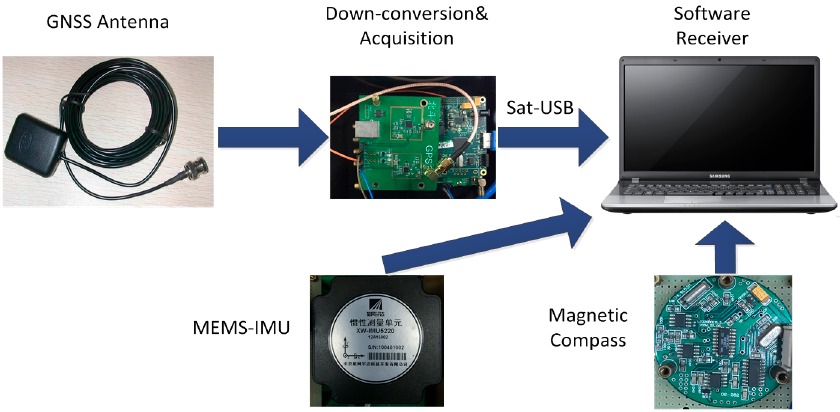
Figure 25. Experimental setup used for the field test.